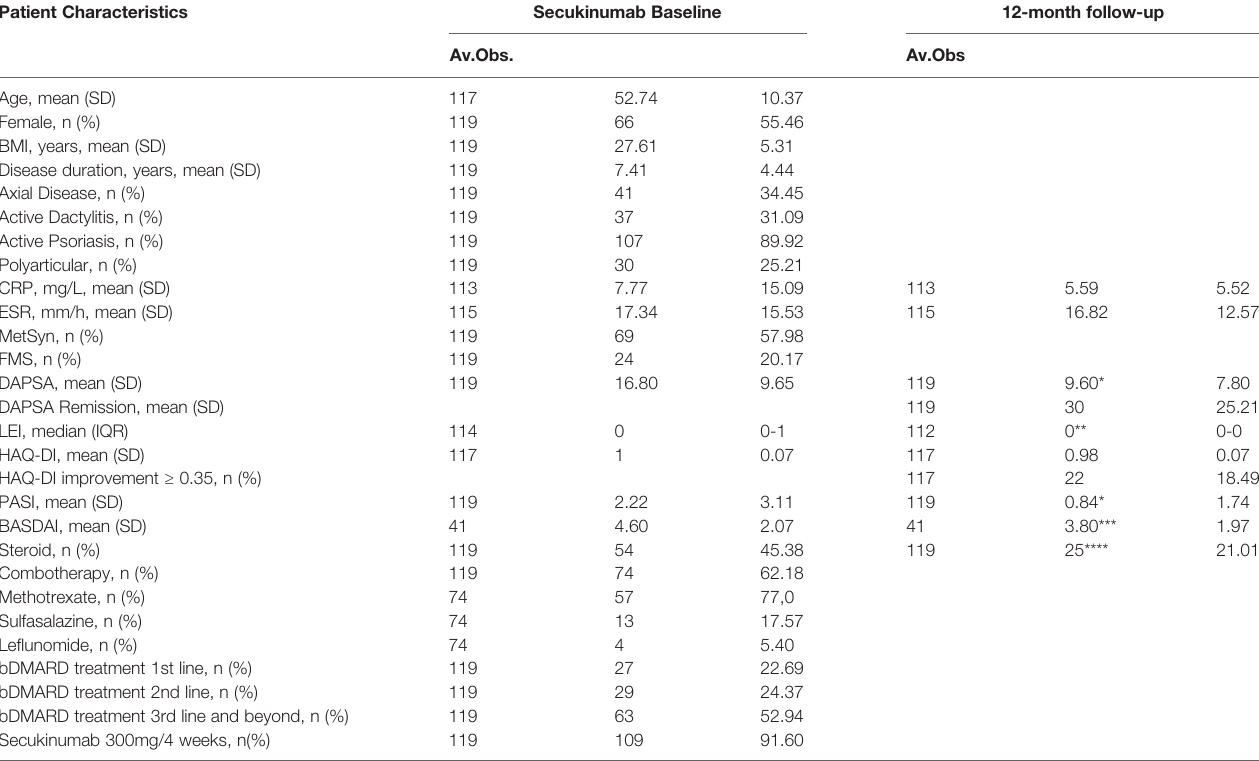
TABLE 1 | Patient